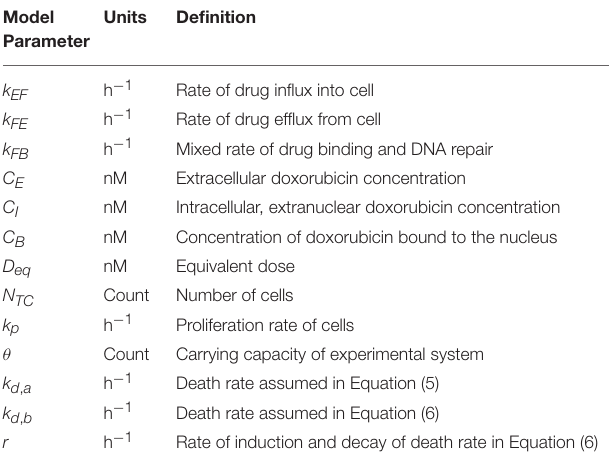
TABLE 1 | Model parameter